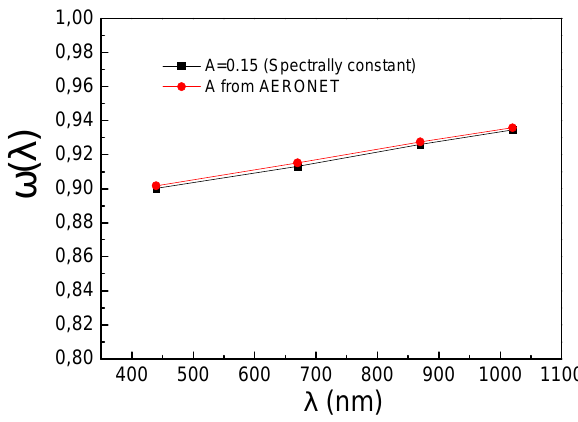
Fig. A4. ω ( λ) retrievals derived for desert dust case (23 June 2008) using a spectrally constant value of 0.15 for the surface albedo (A), and using the spectrally dependent values of A provided by AERONET